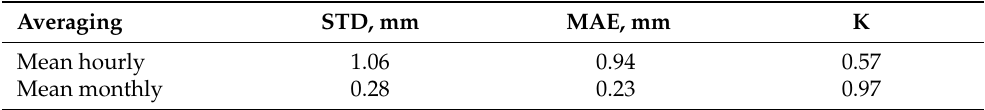
Table 2. Statistical characteristics of PWV variations estimated from Era-5 reanalysis data and radiometric measurement